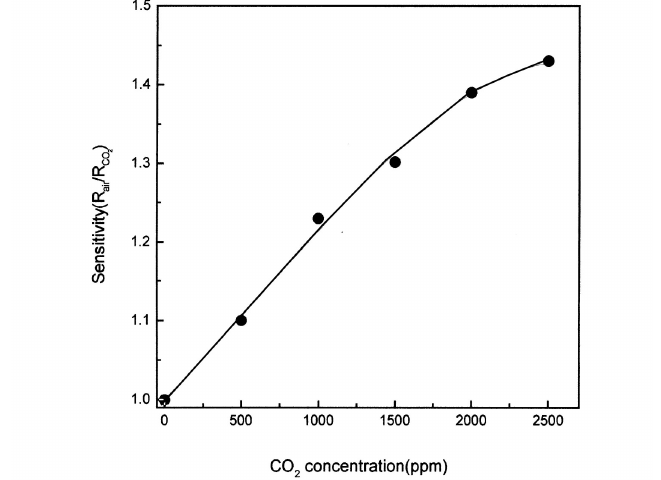
concentration on the signal of the BaTiO 2